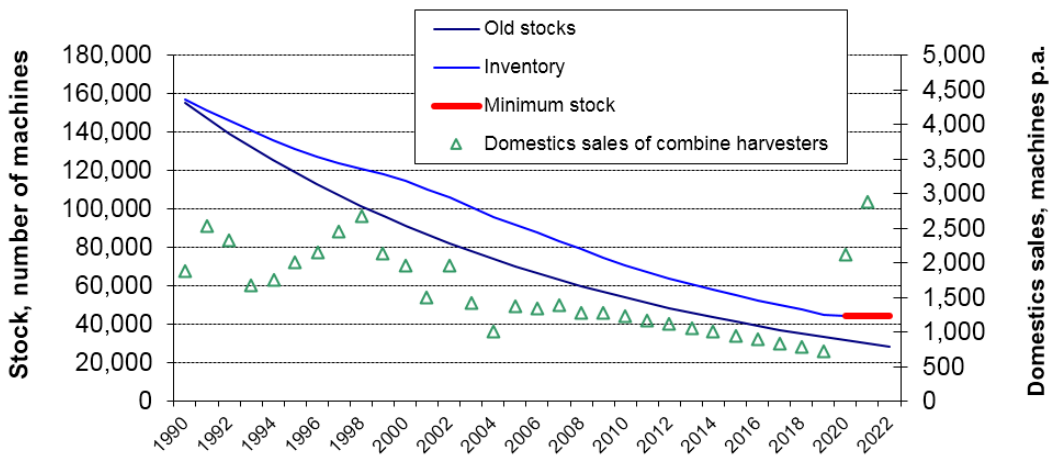
Figure 7. Sales and inventory of combine harvesters (1990–2022). Source: Own calculations based on [9,11].